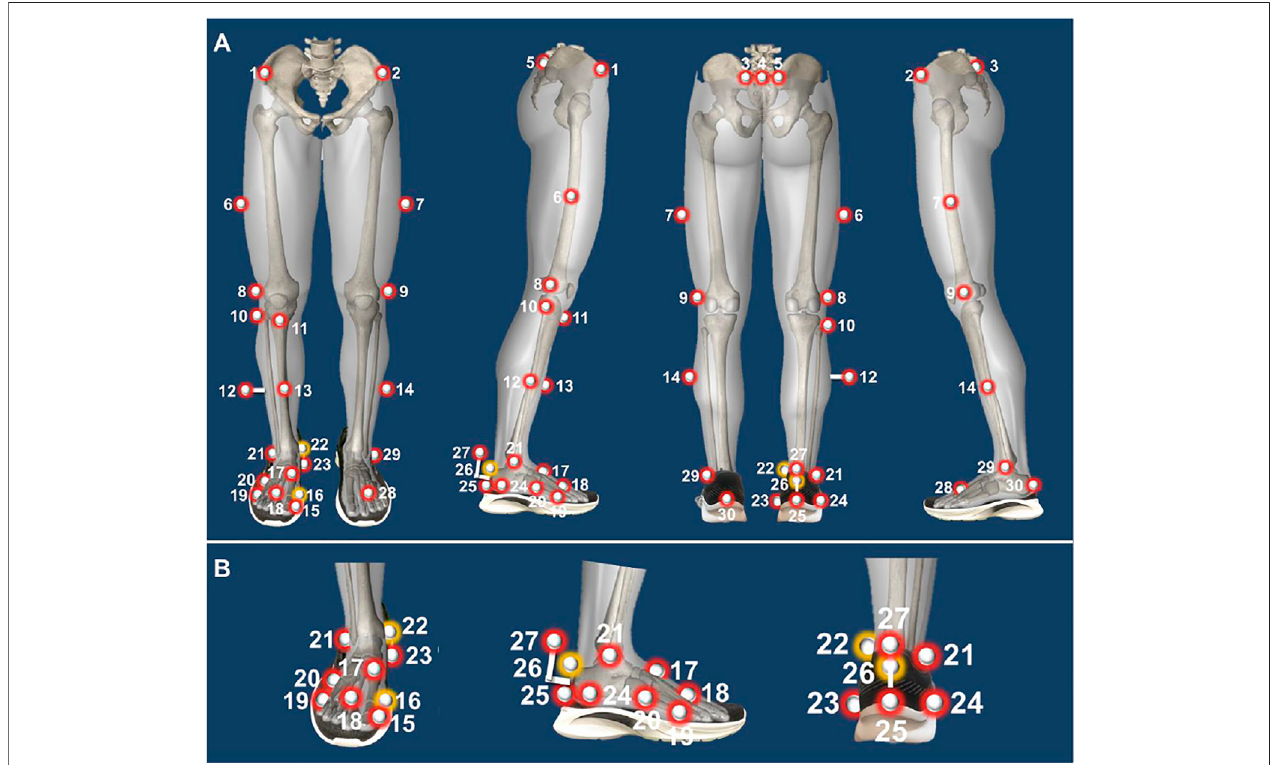
FIGURE 1 | Illustration of Oxford Foot Model marker placement protocol ( (A) : Lower limb model; (B) : Foot multi-segmental model). Note: 1, RASI: right anterior superior iliac spine; 2, LASI: left anterior superior iliac spine; 3, LPSIS: left posterior superior iliac spine; 4, SACR Sacral marker; 5, RPSIS: right posterior superior iliac spine; 6, RTHI: right thigh marker; 7, LTHI: left thigh marker; 8, RKNE: right lateral knee; 9, LKNE: left lateral knee; 10, RHFB: right lateral head of fi bula; 11, RTUB: right tibial tuberosity; 12, RTIB: right tibial marker; 13, RSHN: right anterior aspect of the shin; 14, LTIB: left tibial marker; 15, RHLX: right hallux; 16, RD1M: right 1st metatarsal, distal medial; 17, RP1M: right 1st metatarsal, proximal dorsal; 18, RTOE: right toe; 19, RD5M: right 5th metatarsal, distal lateral; 20, RP5M: right 5th metatarsal, proximal lateral; 21, RANK: right ankle; 22, RMMA: right medial malleoli; 23, RSTL: right sustaniculum tali; 24, RLCA: right lateral calcaneus; 25, RHEE: right heel; 26, RPCA: right posterior calcaneus proximal; 27, RCPG: right peg marker; 28, LTOE: left toe; 29, LANK: left ankle; 30, LHEE: left heel; The yellow markers were removed after static calibration.